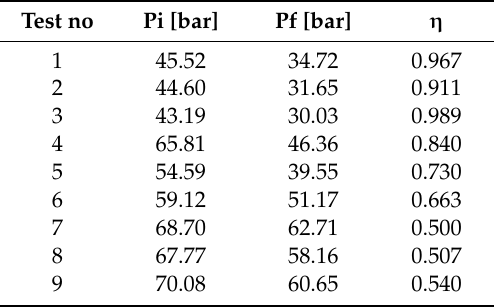
Table 10. Efficiency calculated for CH 4 hydrate formation tests already studied in Rossi et al. (2019) [25]. Test